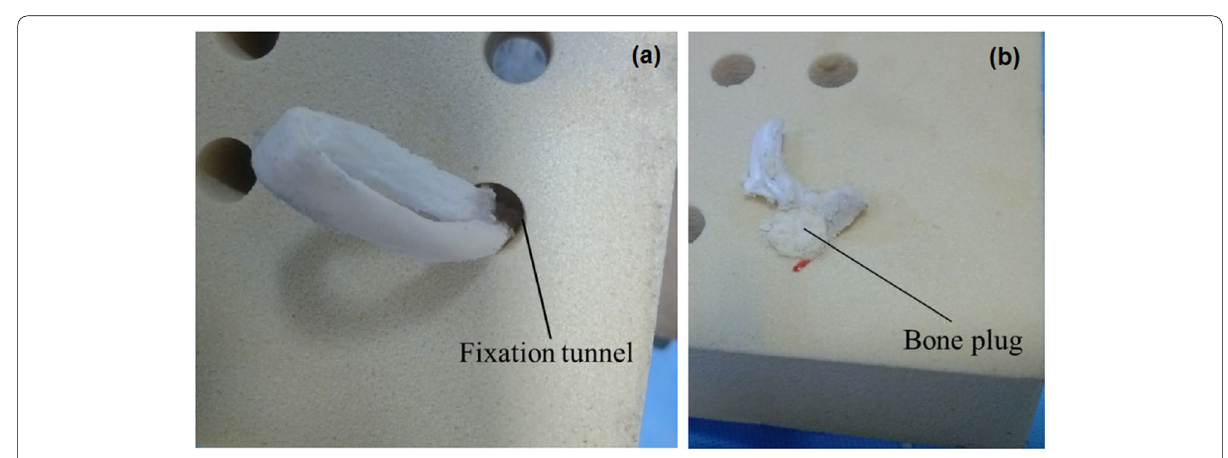
Fig. 6 Top view a and bottom view b of the constructed sample using the CBPF technique